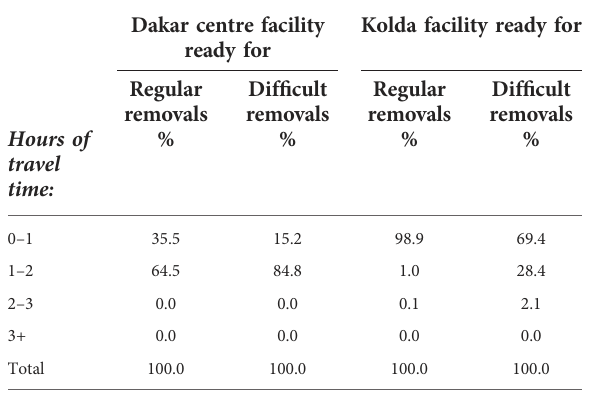
TABLE 4 Proportion of the population of women of reproductive age living within speci fi c one-way travel times of